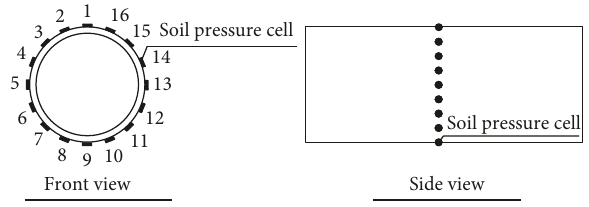
Figure 4: Layout of the measuring